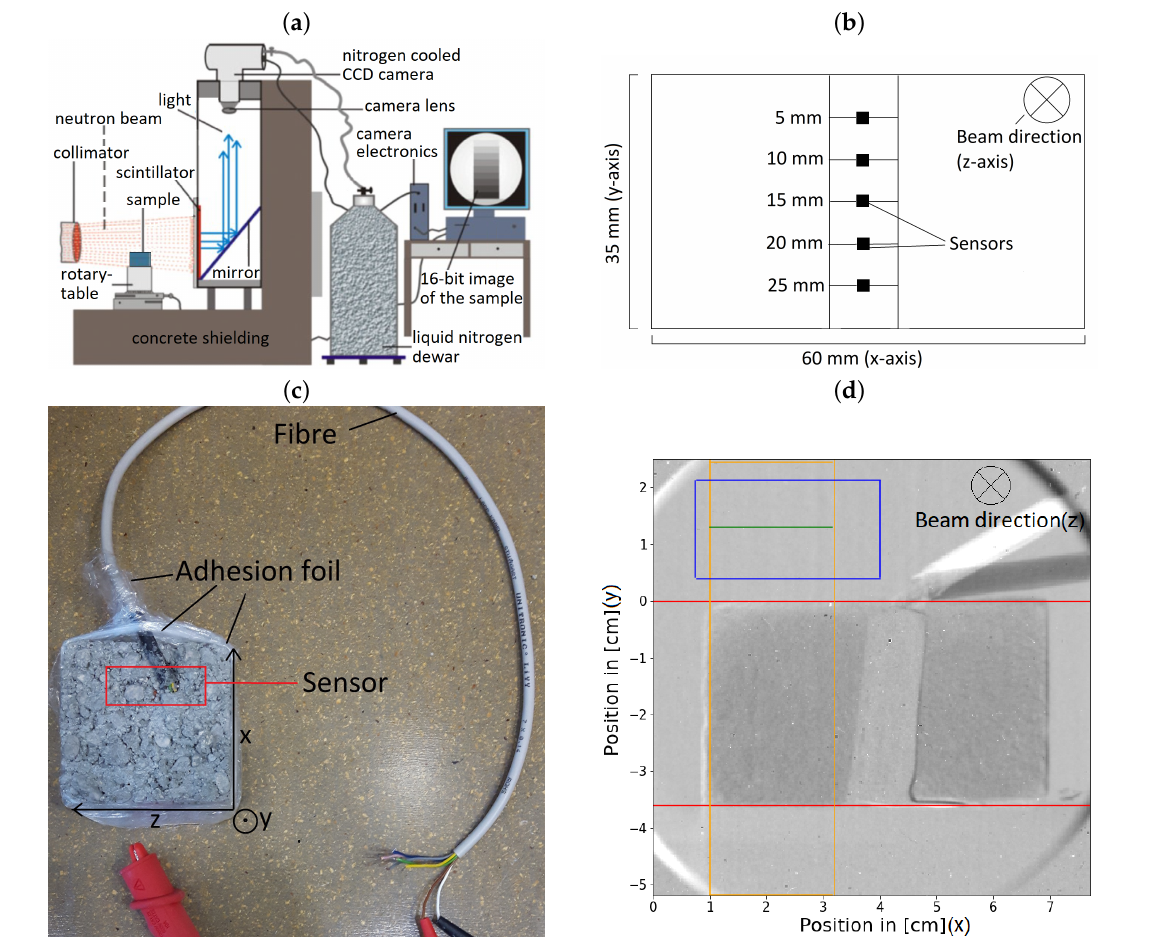
Figure 2. Illustrations of the instrumental setup. ( a ) A collimator directs the neutron beam into the sample, which is placed on a rotary-table. At the scintillator, the transmitting neutrons emit light, which is redirected with a mirror system into a CCD camera. The images are processed by a computer system. ( b ) A schematic of the orientation of the electrical sensors in the sample. ( c ) Wrapping of the sample in adhesion foil to simulate the environment at construction site. The electrical sensorblock, which consists of five sensors, is built in the sample and is connected with a fibre. ( d ) This figure shows an edited image created by the neutron radiography method. An algorithm calculates the averages of the ψ Mx values in the orange box along the horizontal green line according to Equation (7). The blue , y box represents the ψ Mx values which are used to normalise the images. Values of the open neutron , y beam are preferred for the normalisation process, therefore the blue box is located above the